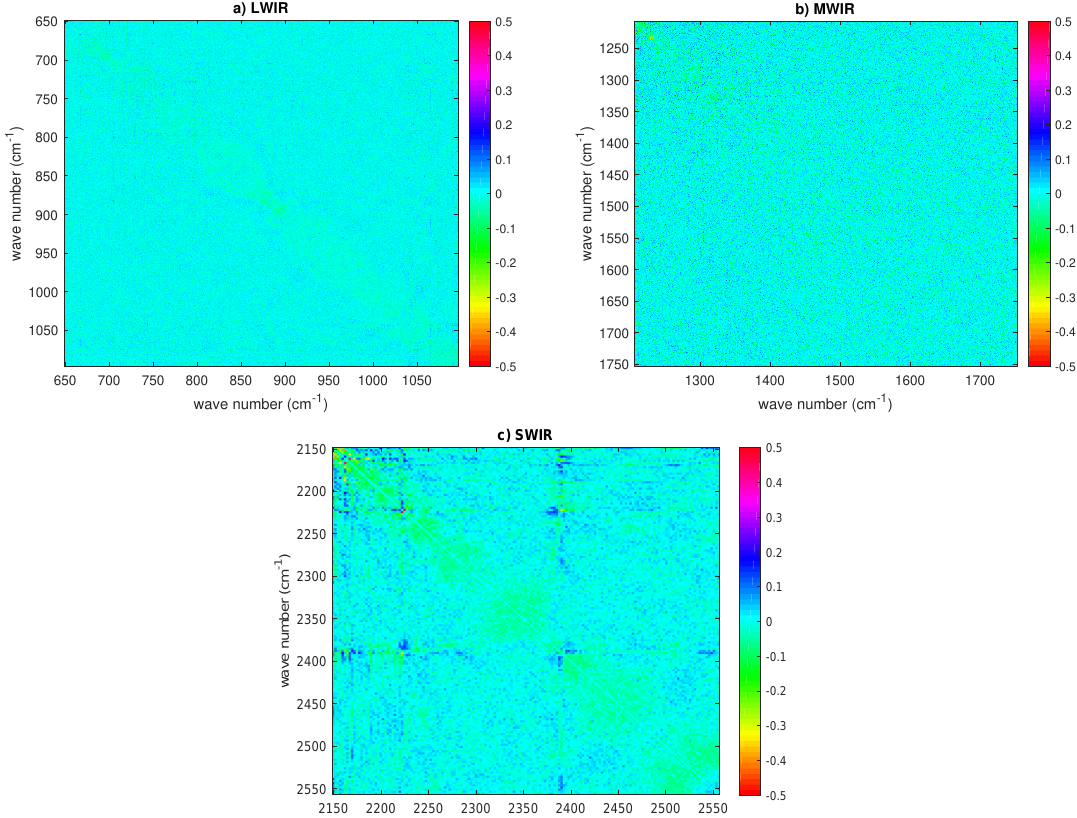
Figure 11. CrIS estimated correlation matrix (data set on 30 September 2015) for: ( a ) LWIR; ( b ) MWIR; and ( c ) SWIR. The sampling is 0.625 (LWIR), 1.25 (MWIR), and 2.5 cm − 1 (SWIR). In all correlation matrices, the diagonal has been subtracted to allow for a better visual inspection for possible correlation patterns. The results have been averaged over the nine CrIS pixels or